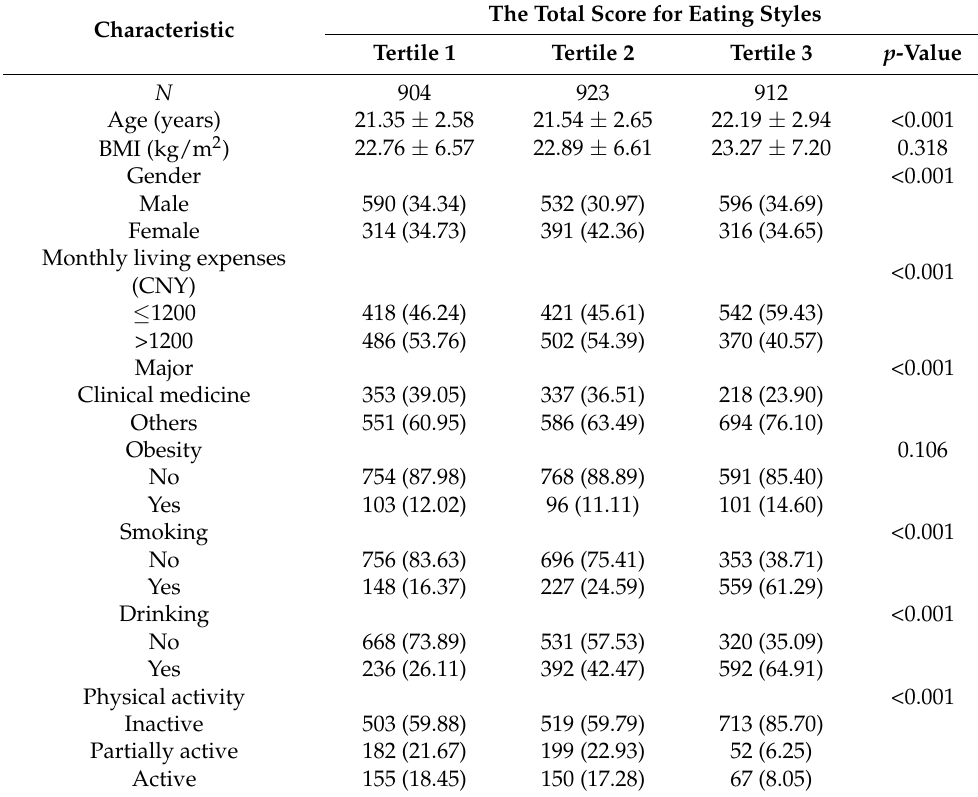
Table 1. Characteristics of participants according to tertiles of eating styles ( n = 2739).